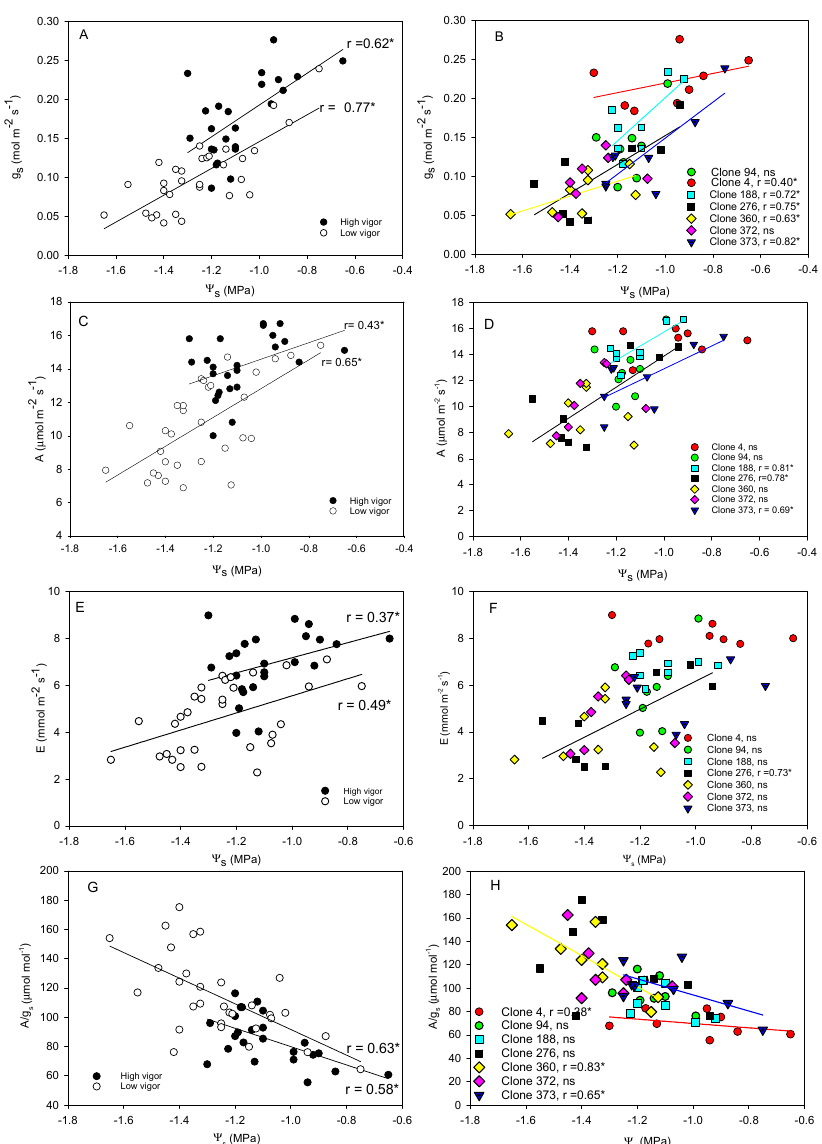
Figure 5. Significant relationships between midday stem water potential ( Ψ s ) and leaf gas exchange parameters measured at midday (12:15–13:45 p.m.) for high (4, 94, and 188) and low/moderate-vigour clones (276, 360, 372, and 373) ( A , C , E , G ) and for each clone ( B , D , F , H ) during the post-veraison period (August) in 2020. Each point represents a single measurement of Ψ s and leaf gas exchange made in the same vine. ns, not significant; *, P <0.05.